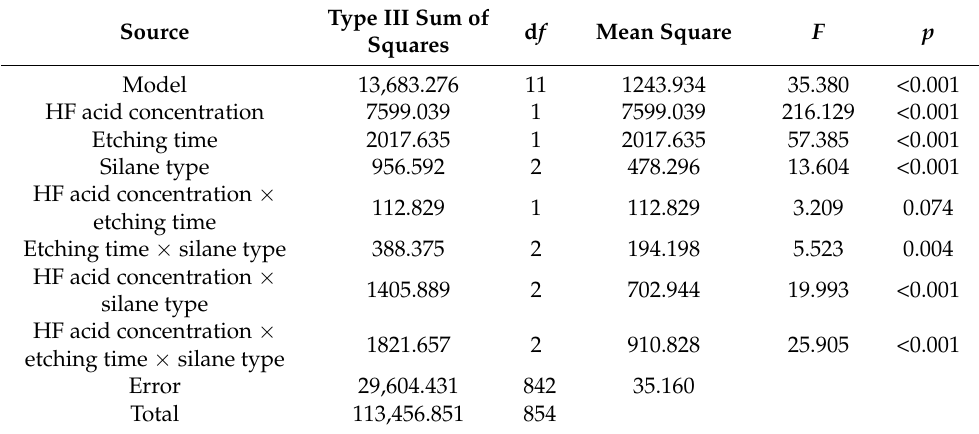
Table 3. Three-way ANOVA results, considering the factors: HF acid concentration, etching time and silane